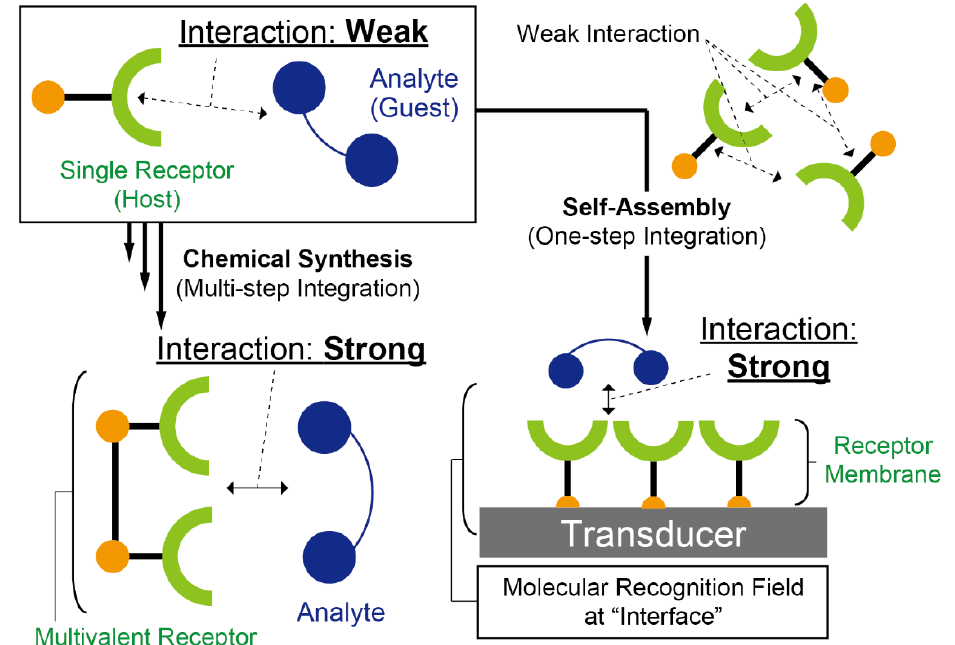
Figure 1. Schematic concept of molecular assembly-based artificial receptor systems for sensing applications. Although the wiring of receptor molecules is an e ff ective strategy to improve molecular interactions between the host receptors and guest analytes, the complicated multi-step process is required for the preparation of the multivalent receptor by using chemical synthesis processes. In contrast, the one-step preparation of the multivalent receptors at the transducer interface can be easily achieved by molecular self-assembly. Hence, the precise design of sensing materials and the expression of their functionality can be e ff ectively achieved by imitating the molecular recognition systems in nature.